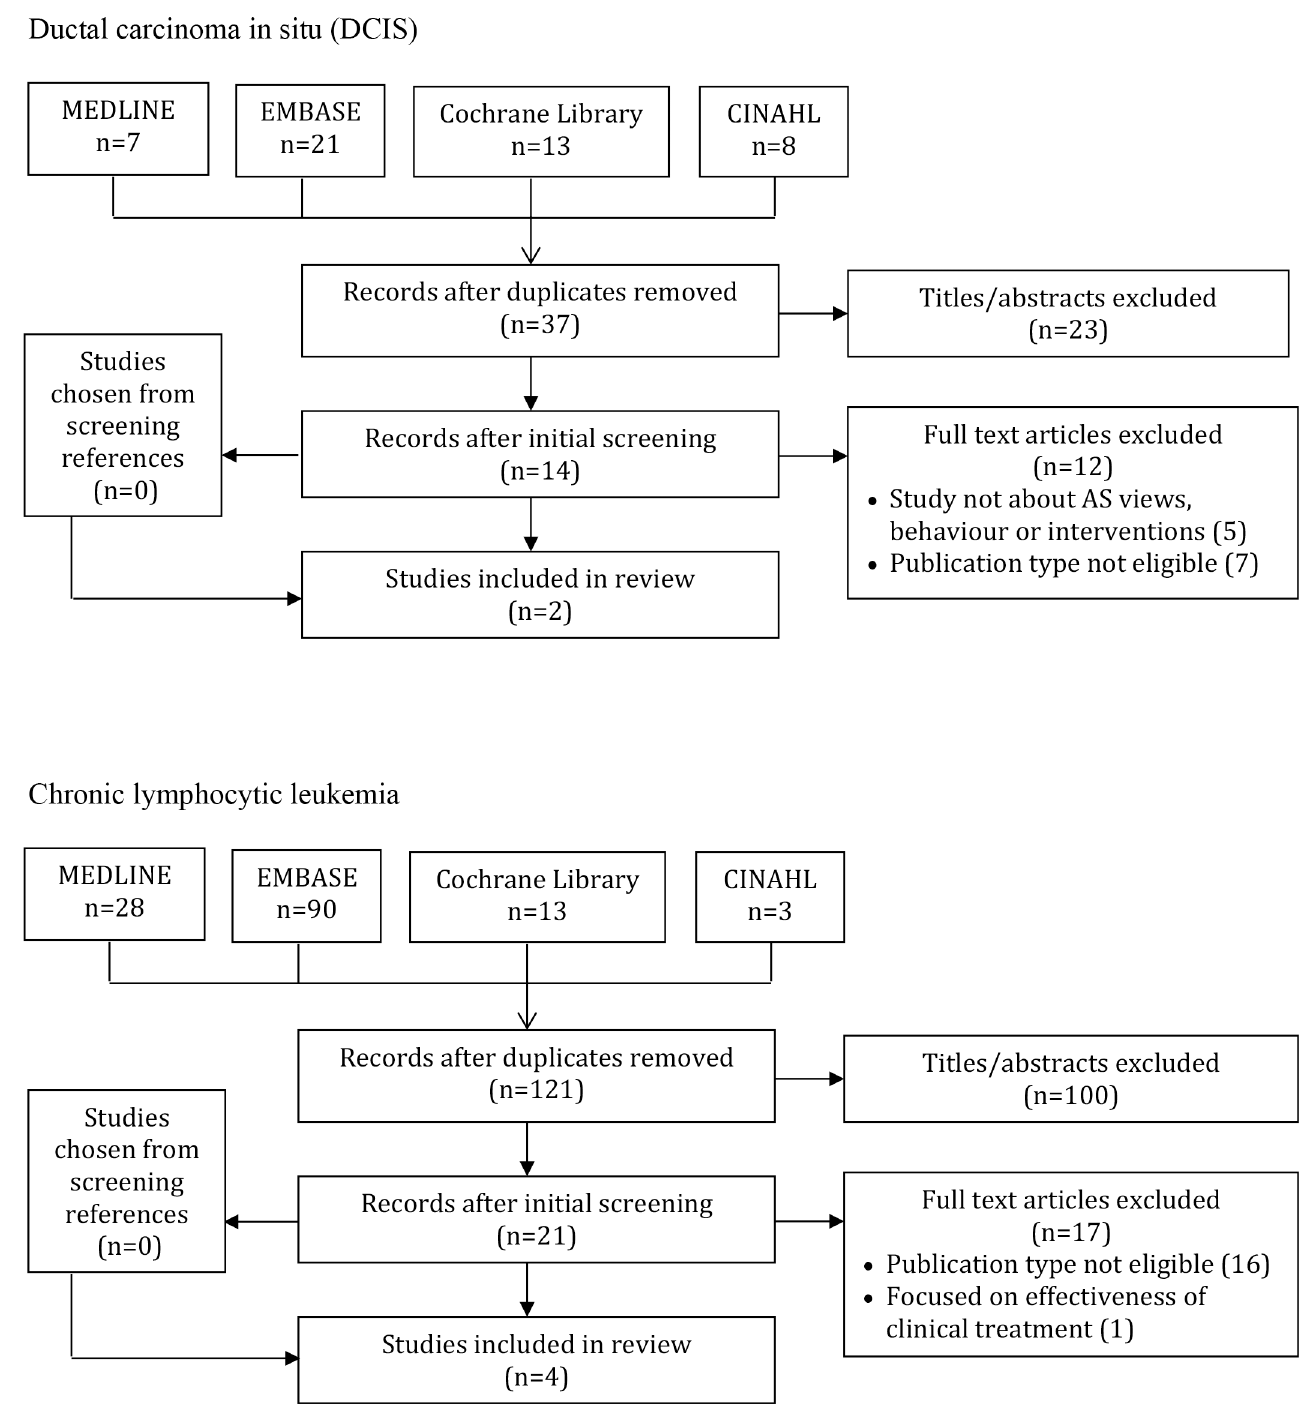
studies that employed cross-sectional questionnaires found that CLL patients undergoing treatment experienced significantly lower quality of life compared with those undergoing WW: emotional and social functioning (p = 0.004) and fatigue (p = 0.021) [26]; or AS: